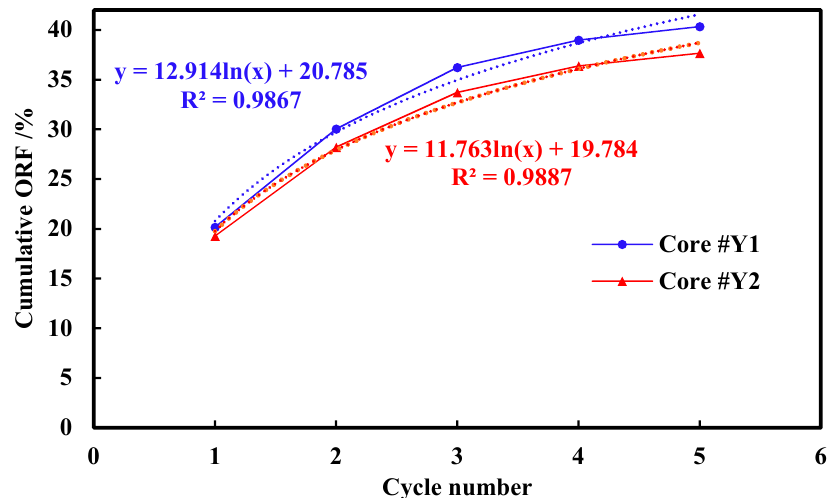
Figure 8. Cumulative ORF versus cycle numbers.